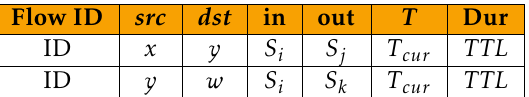
Table 1. Switch’s flow table entry (FTE)